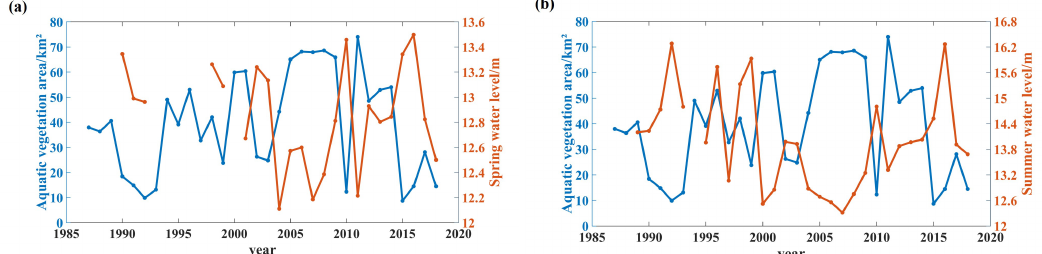
Figure 10. Decadal variations of aquatic vegetation area and water level for Longgan Lake from 1987 to 2019. ( a ) Aquatic vegetation area related to water level in spring; ( b ) Aquatic vegetation area related to water level in